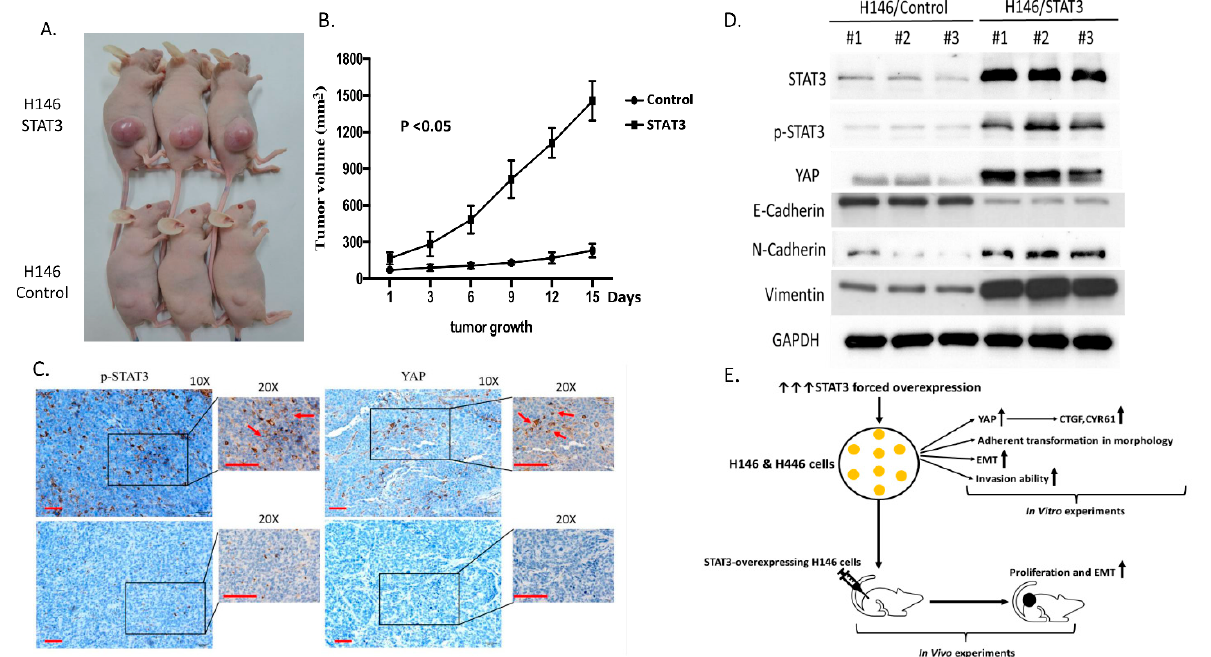
Figure 5. STAT3 overexpression increased the tumor proliferation ability of H146 cells in a xenograft mouse model. ( A , B ) STAT3-overexpressing H146 cell tumors grew significantly more rapidly than control H146 cell tumors ( p < 0.05). ( C ) Histological analysis of mouse xenograft tissue showed that p-STAT3 and YAP immunohistochemistry (IHC) staining increased in STAT3-overexpressing H146 cell tumors compared with control H146 cell tumors. Scale bar = 100 µm. ( D ) WB of STAT3, p-STAT3, YAP, E-cadherin, N-cadherin and vimentin protein expressions in STAT3-overexpressing and control tumors. ( E ) Experimental framework scheme of this study.